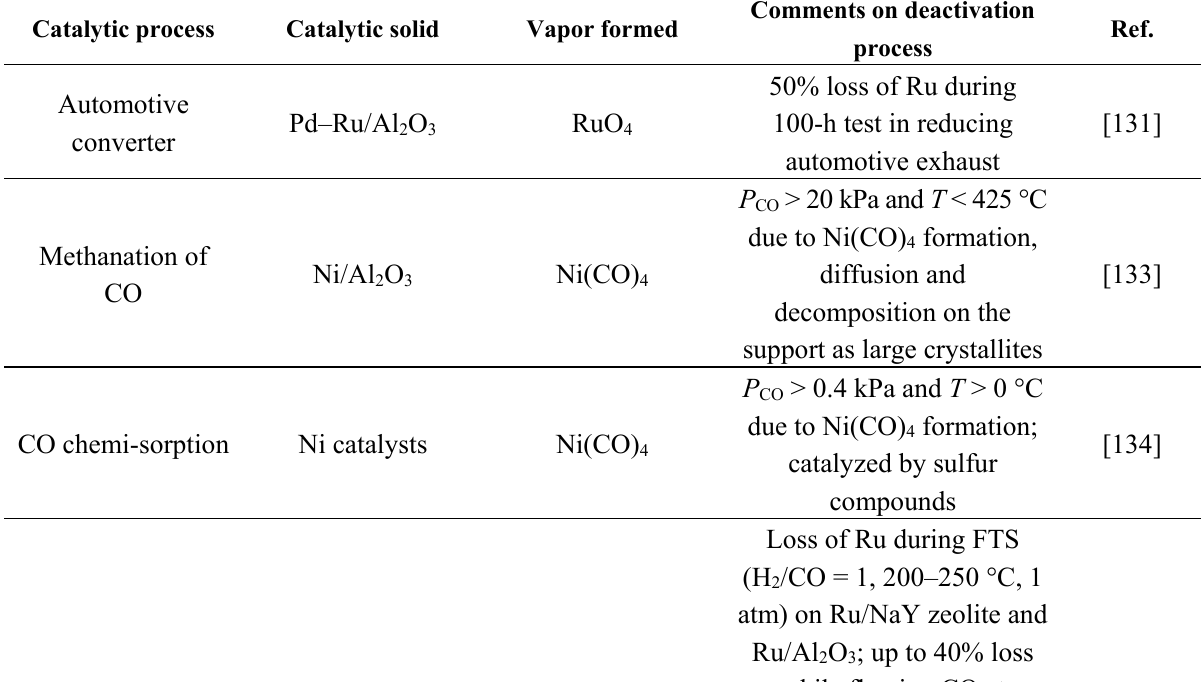
Table 13. Documented Examples of Reactions of Vapor with Solid to Produce Volatile